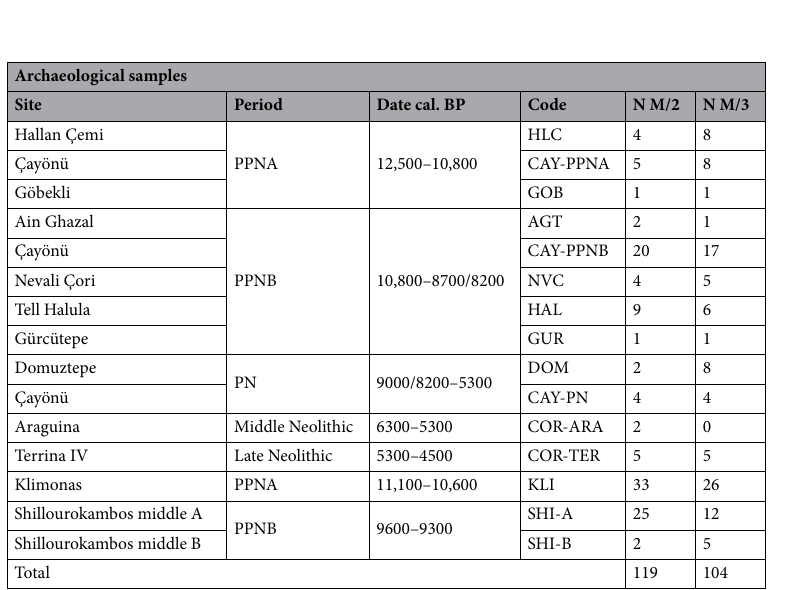
Table 2. Archaeological samples of Sus scrofa selected for dental Geometric